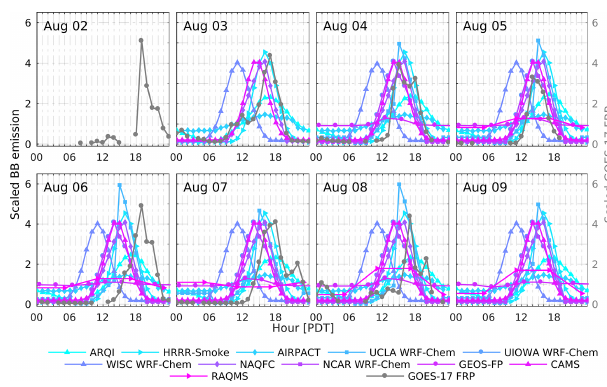
Figure 4. Diurnal variation factors of biomass burning emissions from the Williams Flats fire on 2–10 August 2019 scaled by daily average value. The colored lines with markers represent different models. The grey lines with dots represent the scaled GOES-17 fire radiative power (FRP). The lines for NCAR WRF-Chem overlap with UIOWA